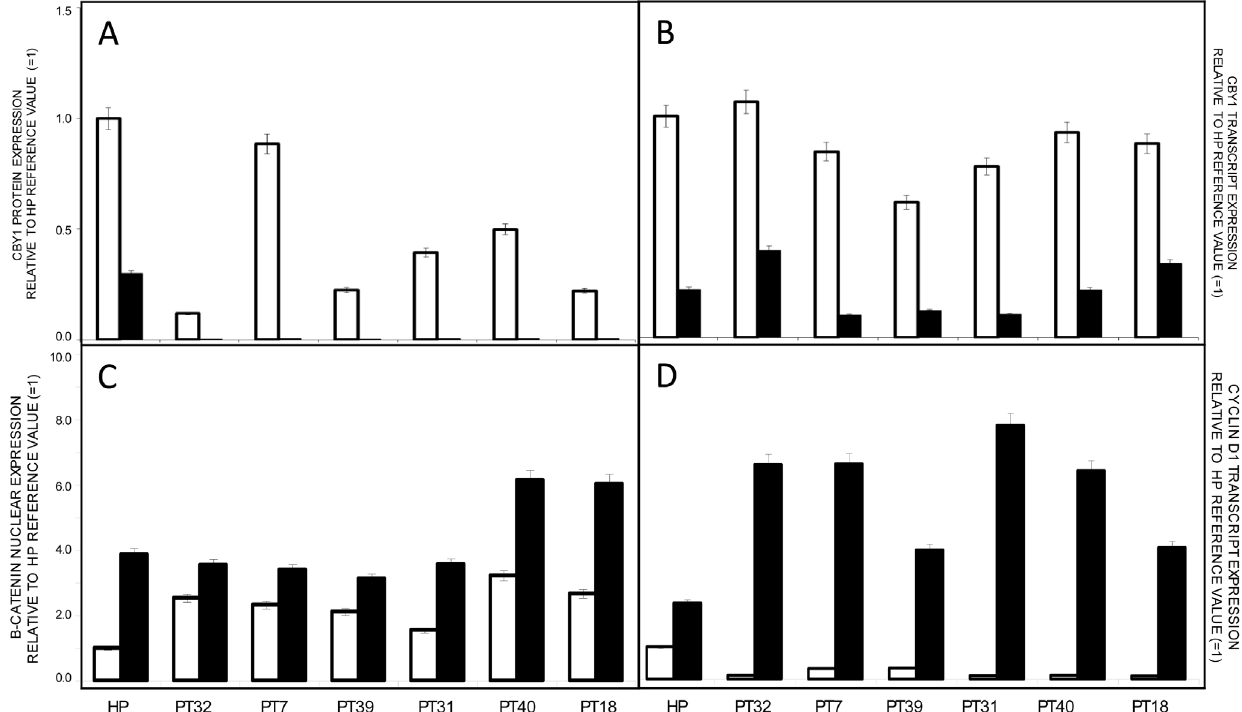
Figure 4. Prominent reduction of Cby1 expression in the putative LSC compartment identified by a CD34 + phenotype. The expression of Cby1 protein ( A ) and transcript ( B ) was significantly reduced (p , 0.001 or less) in bone marrow CD34 + early progenitors of 6 CML-CP patients at diagnosis (black columns) compared with MCF (white columns). Cby1 reduction in CD34 + cells was associated with a significant increment of nuclear beta catenin protein ( C ) and cyclin D1 transcript ( D ) (p , 0.05 or less). Cby1 reduction and nuclear beta catenin and cyclin D1 increments were also seen in CD34 + cell from HP. As in Figures 3 and 4, WB and PCR signal intensities of RNA and protein pools of HP were normalized to 1 and kept as reference of Cby1 expression in either cell type (see Table S4 for details on ratios and Figure S4 for blot